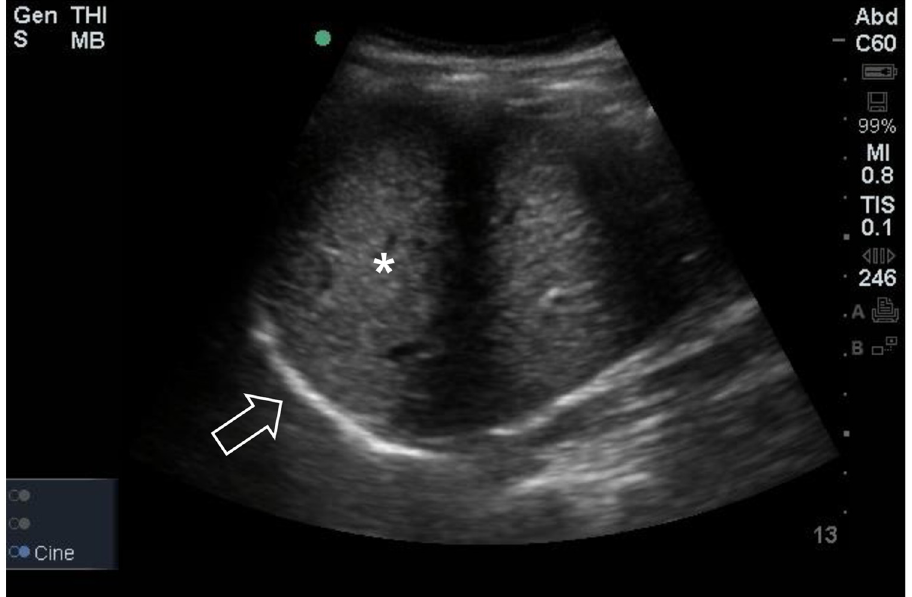
Fig 1. Diaphragmatic excursion as measured using 2D mode sonography. With the probe fixed on the right midaxillary line at approximately the sixth to ninth intercostal spaces, the ultrasound beam was directed to the hemidiaphragmatic domes at an angle of about 70 degrees. The diaphragm (white arrow) is located cephalad to the liver < asterisk > .